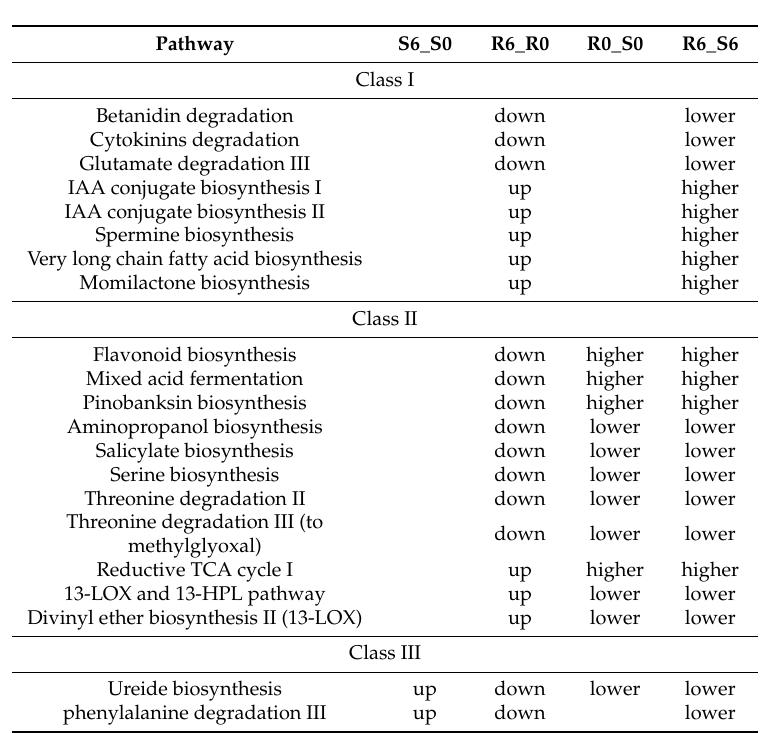
Figure 1. The Venn diagram showing the differentially regulated metabolic pathways identified by the Omics Viewer. The numbers in the Venn diagram are the number of the differentially regulated metabolic pathway that belongs to each category in the Venn diagram. Table 2. The identified SBPH resistance-related metabolic pathways and its differential regulation in the four comparisons.